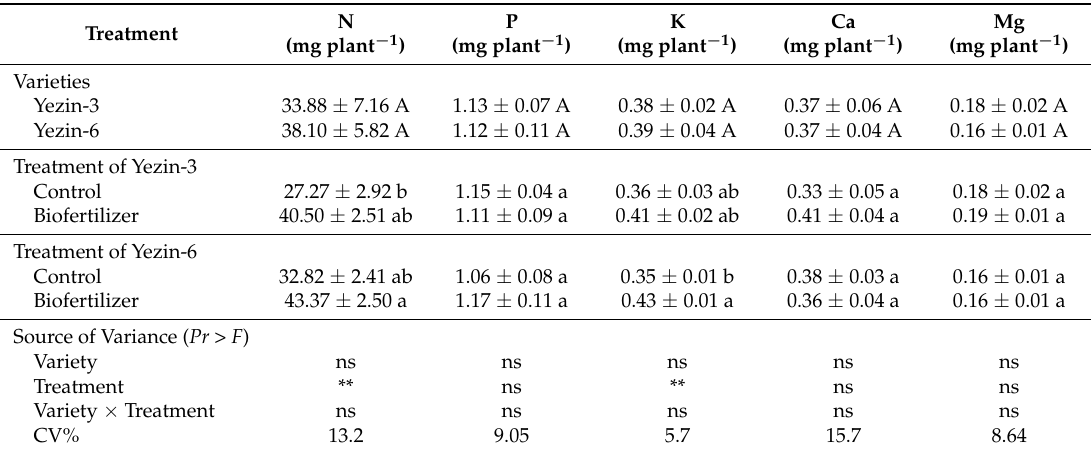
Table 6. Effect of biofertilizer on N, P, K, Ca and Mg uptakes of Yezin-3 and Yezin-6 soybean varieties at V6 stage.